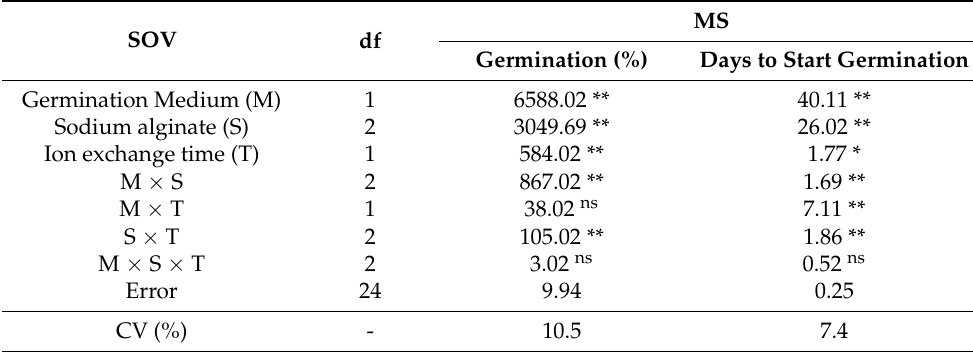
Table 1. Analysis of variance of germination medium effect, sodium alginate concentrations, and ion exchange time on the percentage of germination and the number of days for artificial seed germination in S. pennata . MS SOV df Germination (%) Days to Start Germination Germination Medium